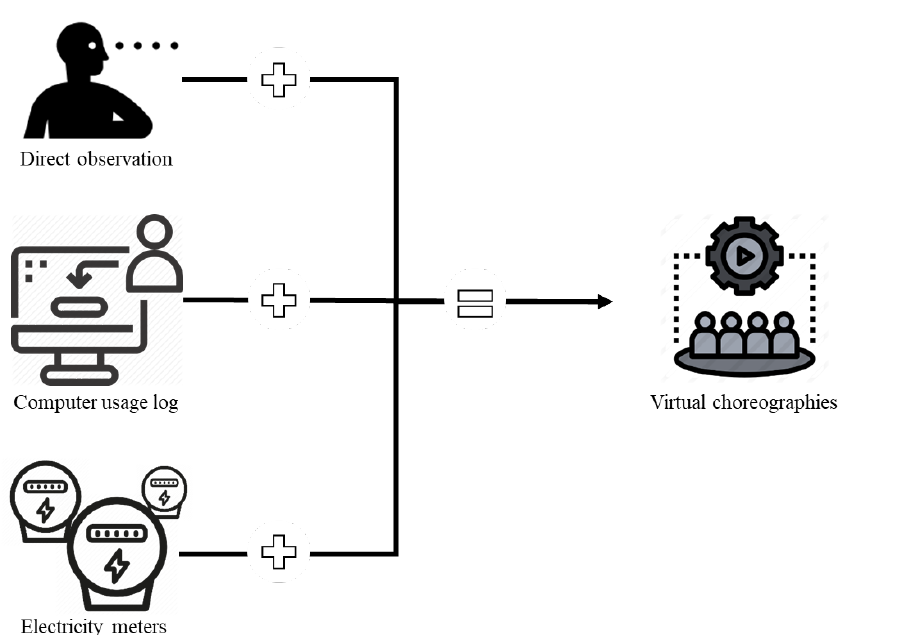
Figure 1. Sources of data that fed into the evaluation of the